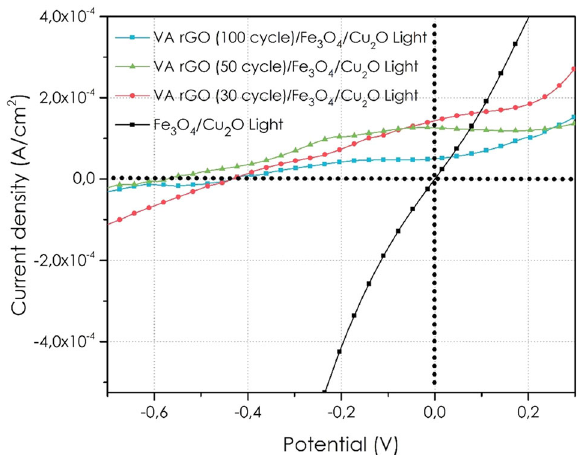
Fig. 5 Current-voltage behaviour of the heterojunctions. Micro J-V behavior of the champion devices of VA r-GO/Fe 3 O 4 /Cu 2 O hetero- junctions campered with bare Fe 3 O 4 /Cu 2 O under 1 Sun illumination.